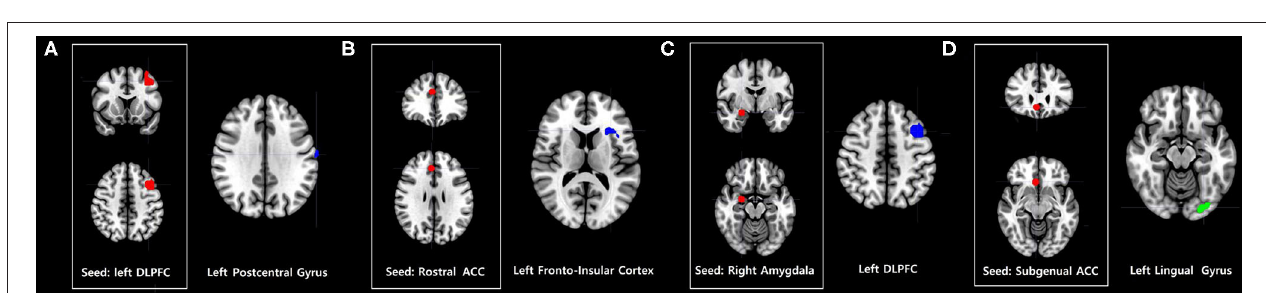
FIGURE 1 | Increases and decreases in dorsal anterior cingulate cortex (dorsal ACC) and frontoinsular cortex-based functional connectivity (FC) in problematic smartphone users, compared to controls. All imaging analyses were corrected for multiple comparisons using a combination of voxel-level thresholds ( p < 0.001) and cluster extent threshold false discovery rate correction ( p < 0.05). (A) Dorsal ACC-based FC was enhanced with the left anterior frontoinsular cortex in problematic smartphone users, compared to controls. (B) Left frontoinsular cortex-based FC was decreased with left ventrolateral prefrontal cortex (VLPFC) and left dorsolateral prefrontal cortex (DLPFC) in problematic smartphone users, compared to controls. (C) Left frontoinsular cortex-based FC was enhanced with precuneus, right supramarginal gyrus, right orbitofrontal cortex and dorsal ACC.